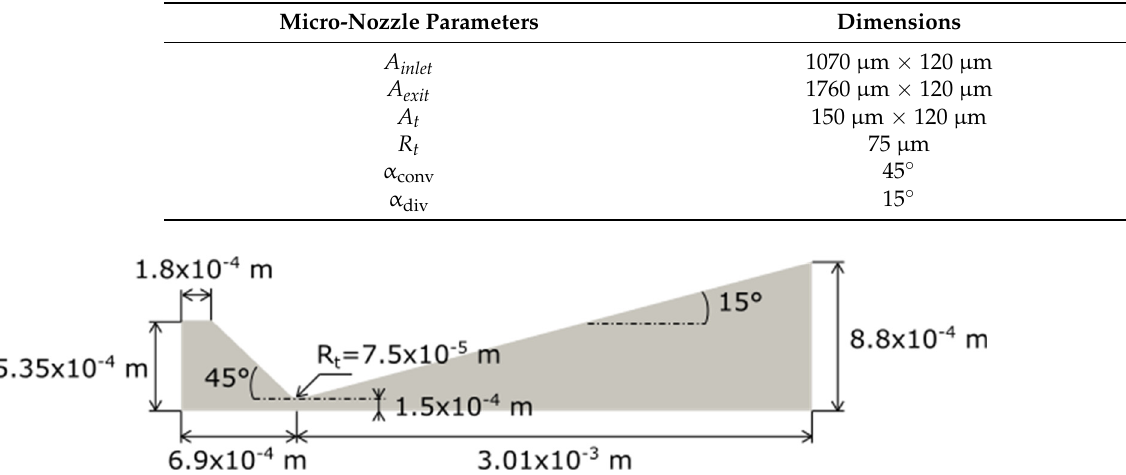
Figure 1. Planar characteristics of the symmetrical half geometry of the micro-nozzle [33].